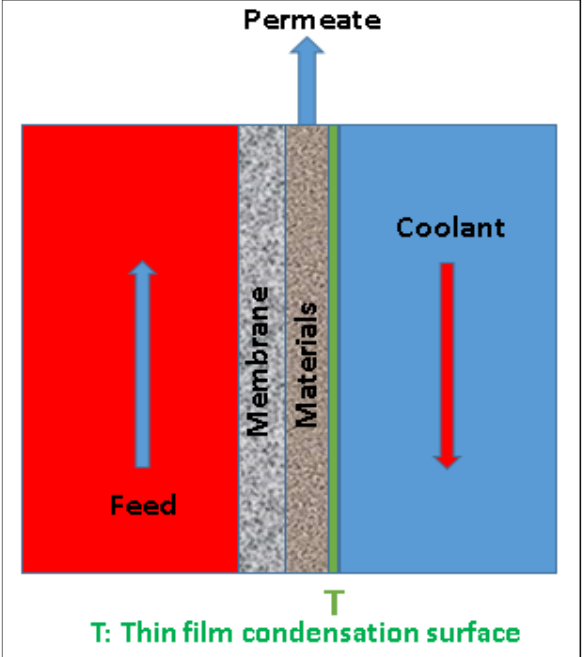
Figure 4. Schematic of a material gap membrane distillation (MGMD)